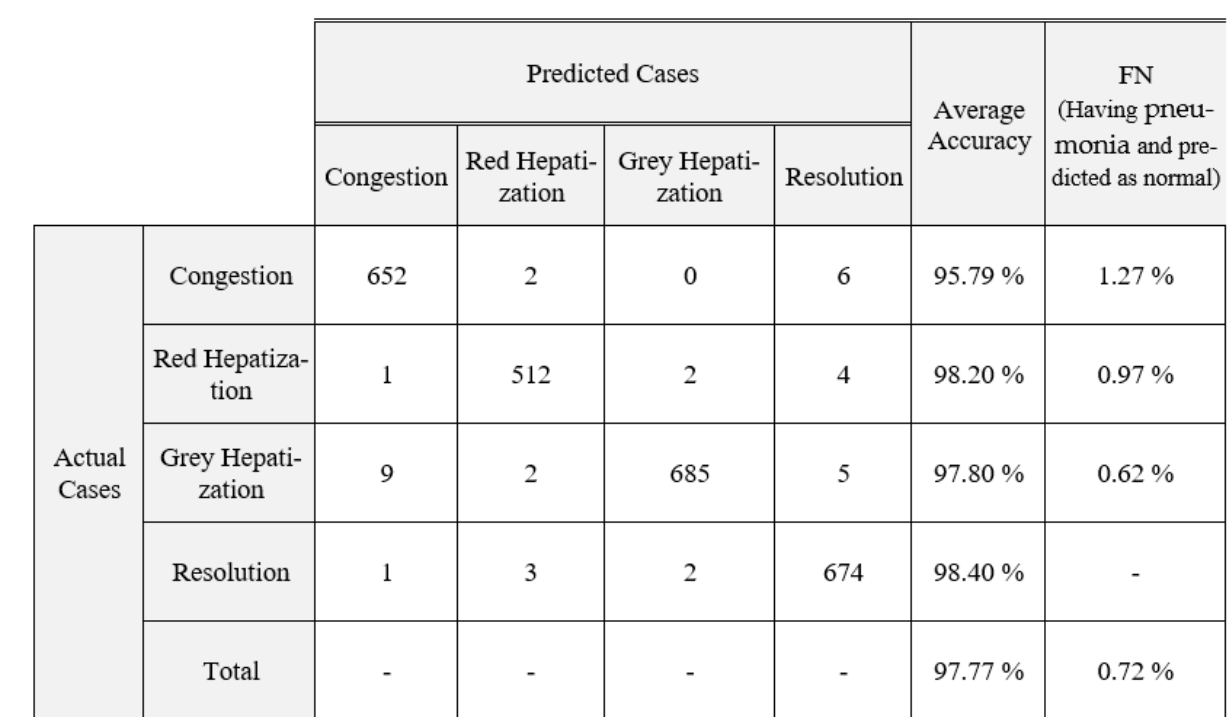
Healthcare 2022 , 10 , x FOR PEER REVIEW 12 of 14